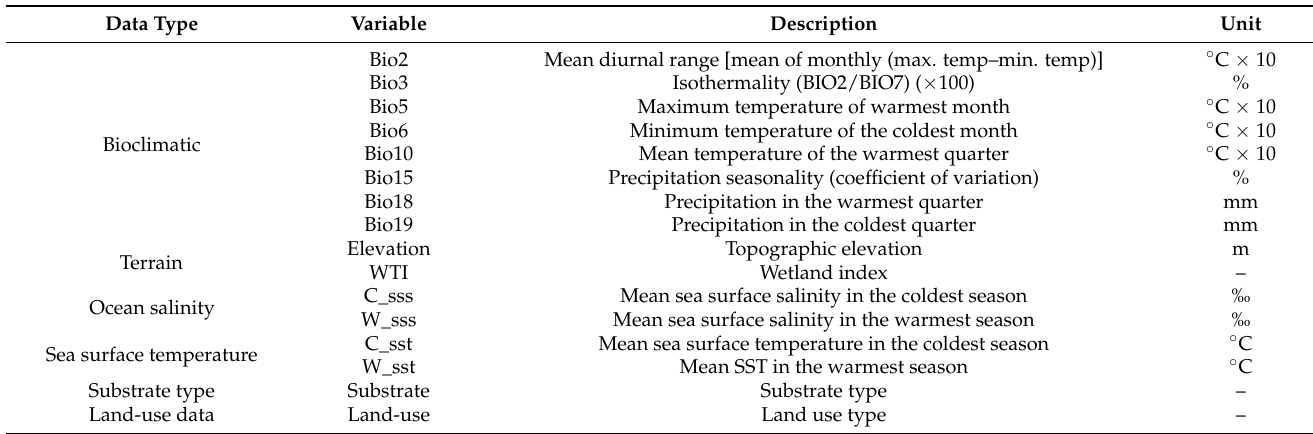
Table 2. Environmental variables used to predict the mangrove distributions in the Beibu Gulf, Guangxi,